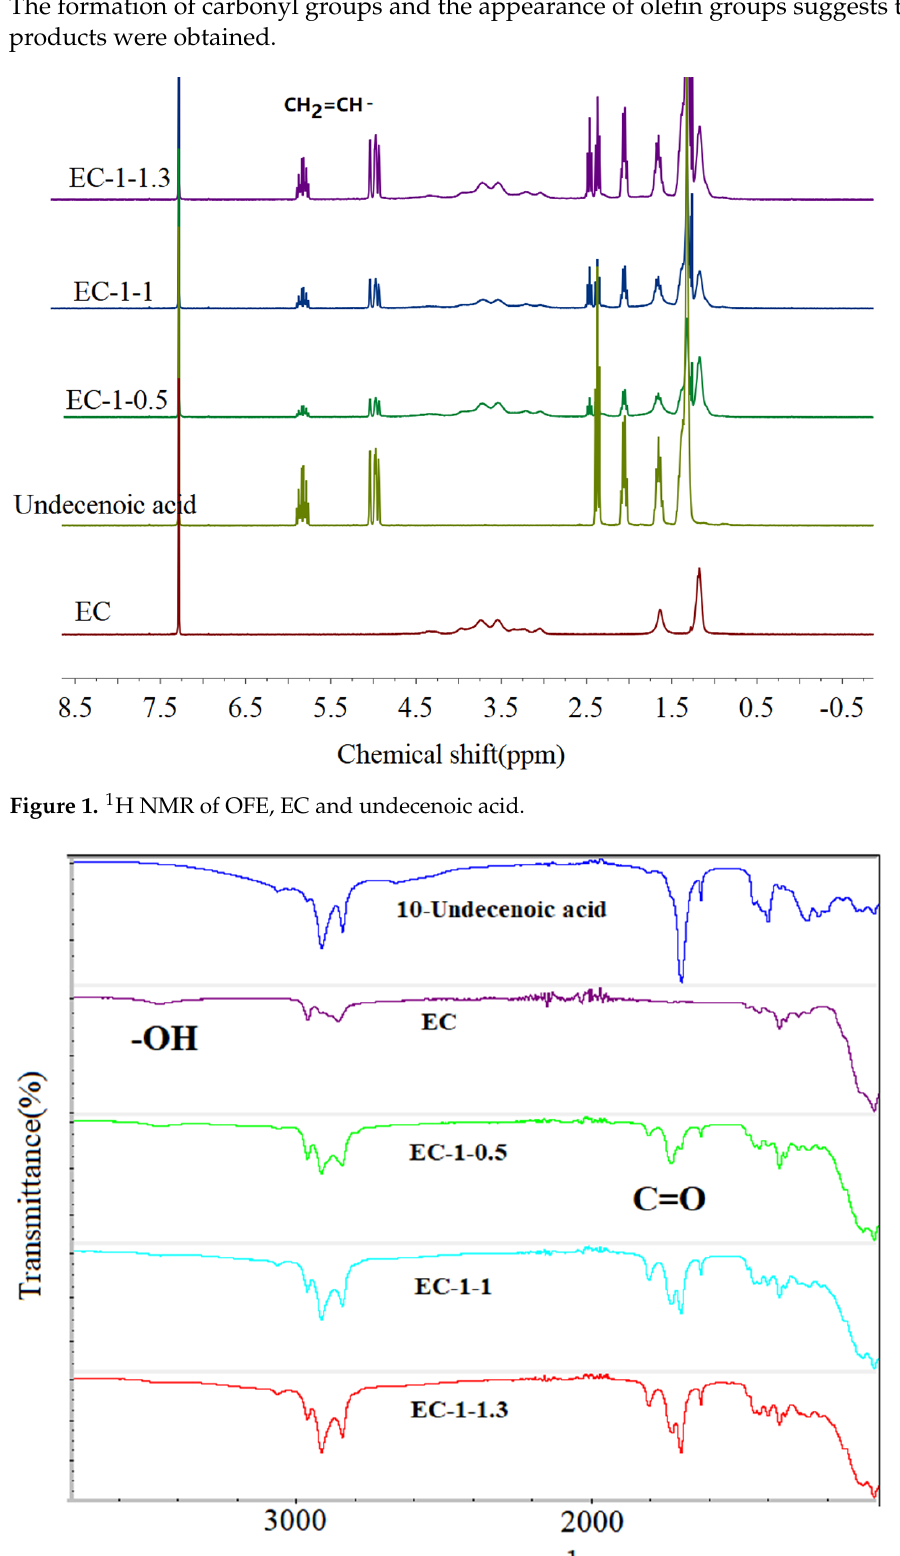
Figure 2. FT − IR of OFE, EC and undecenoic acid.